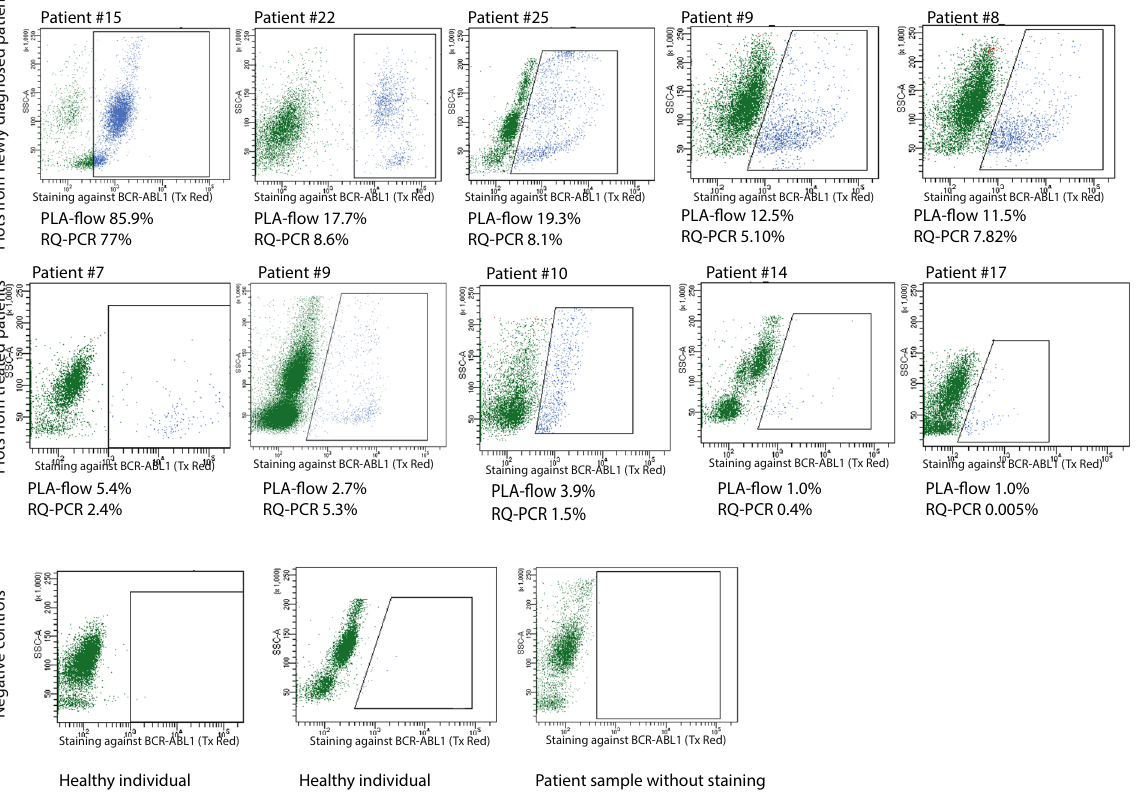
Figure 3. PLA-flow detection of BCR-ABL1 positive cells from patients diagnosed with CML and normal controls. The top row dot-plots are examples from analysis with PLA-flow of newly diagnosed patients, while the middle row represents patients previously treated or under treatment. At the time for sample collection, patients 7 and 9 were treated with imatinib, patient 10 did not receive any treatment and patients 14 and 17 were treated with dasatinib. The cells were gated first for side and forward scatter and then a positive gate was placed around cells that were considered positive compared to a negative control. The negative control used for gating was a patient sample that was not subjected to any PLA probes. The bottom row displays examples of the negative controls, i.e. two samples from healthy individuals and one sample from a patient where no PLA probes were added. The patient samples were also analyzed with RQ-PCR to estimate BCR-ABL1 transcript levels. Results from both analyses are indicated below each plot where